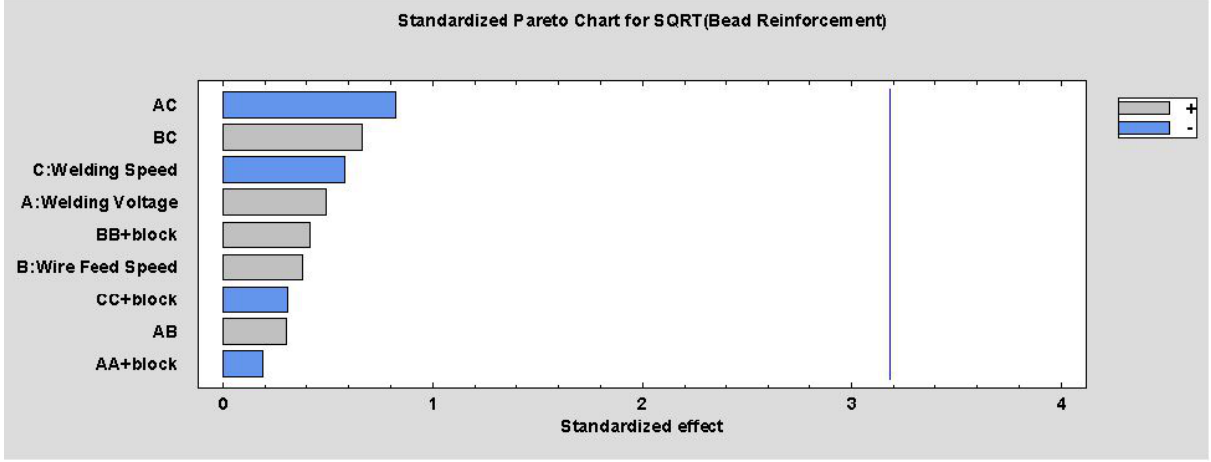
Figure 6. Pareto Chart for SQRT of Reinforcement height